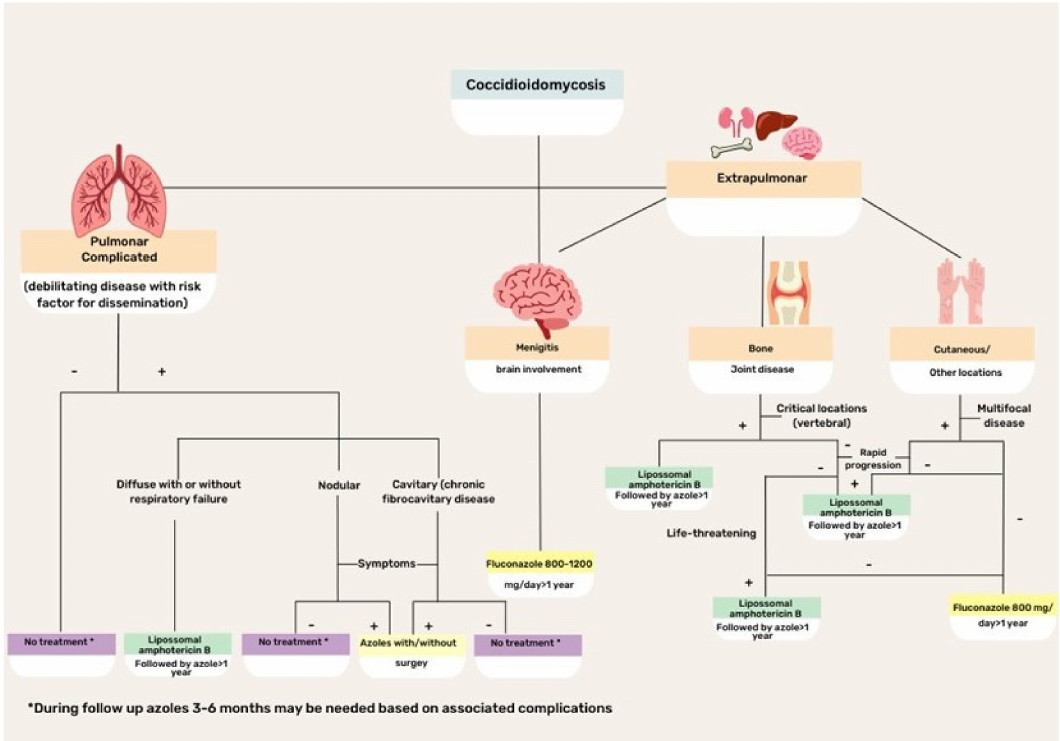
Figure 4. Flowchart illustrating the treatment of different clinical forms of